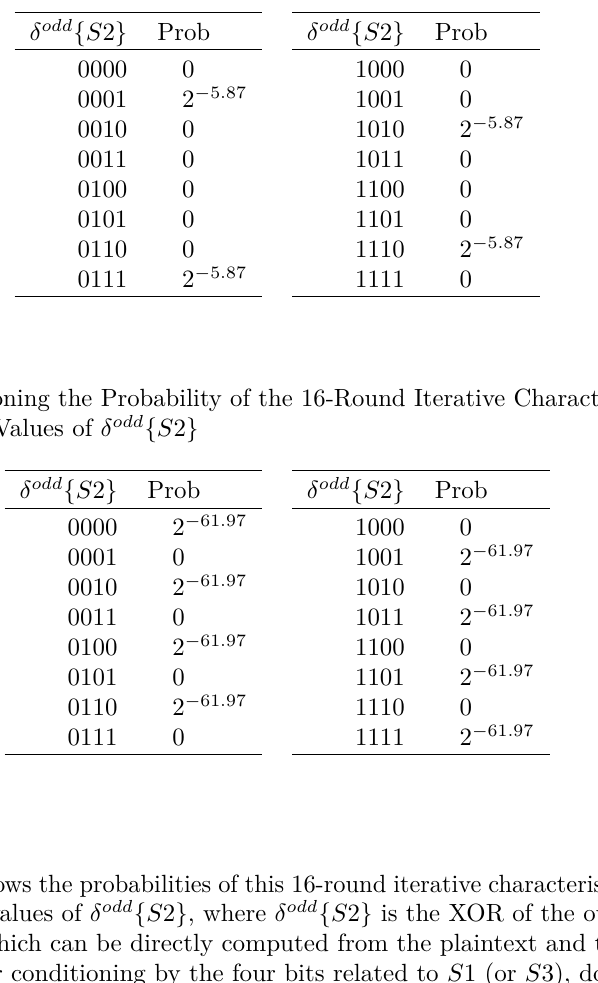
Table 19: Conditioning the Probability of Ω 1 on Each of the 16 Possible Values of δ odd { S 2 } δ odd { S 2 }